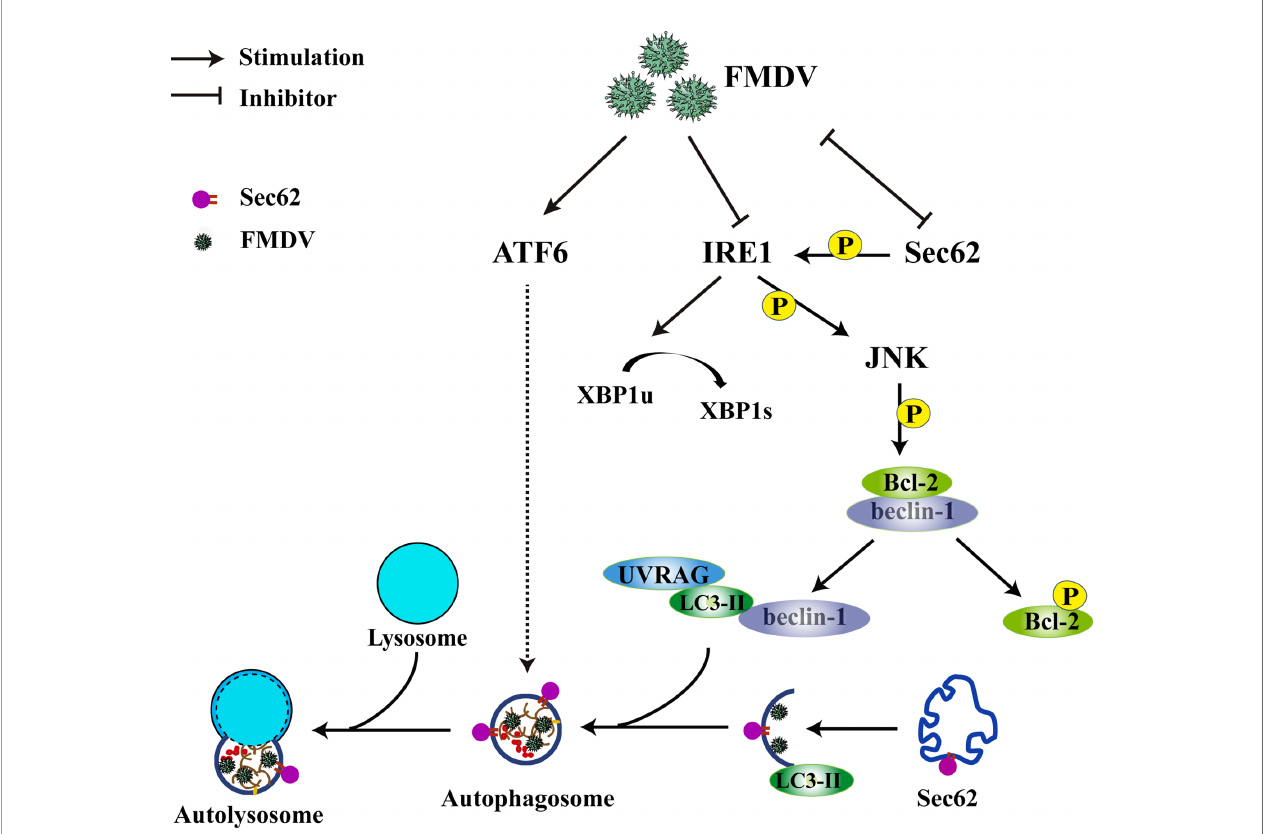
FIGURE 7 | Schematic of how Sec62 regulates FMDV-induced autophagy. FMDV infection activates ATF6 signaling and inhibits the expression of Sec62 and IRE1 a . The ATF6 pathway of UPR indirectly participates in FMDV-induced autophagy. Sec62 activates the IRE1 a -JNK signaling pathway through phosphorylating IRE1 a and recruits autolysosomes to attenuate ER stress and block FMDV